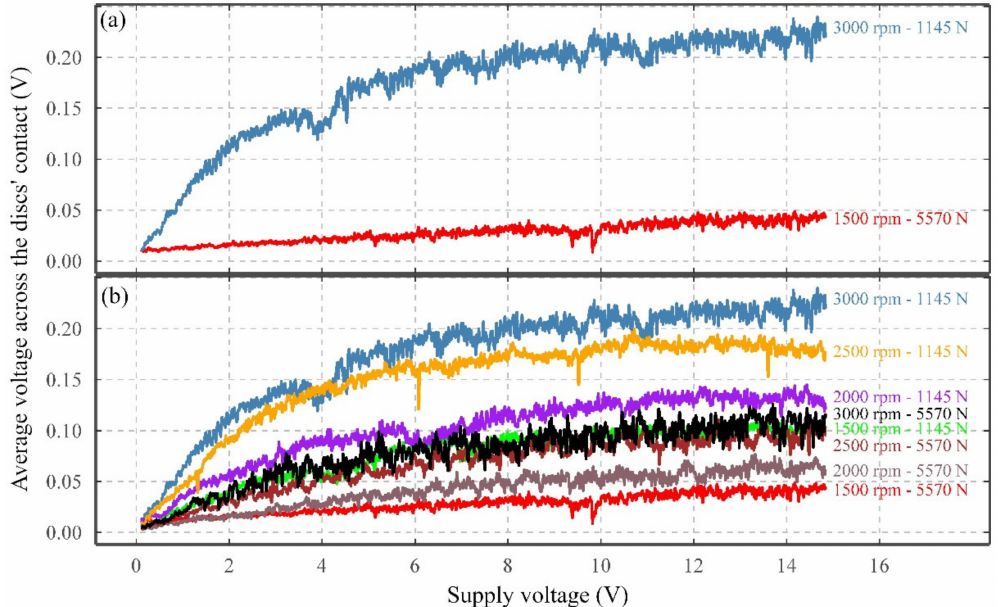
Figure 7. Influence of supply voltage on the average VADC for ( a ) two cases with the highest and lowest resultant average VADC and ( b ) selected cases with the highest and lowest loads, and all the